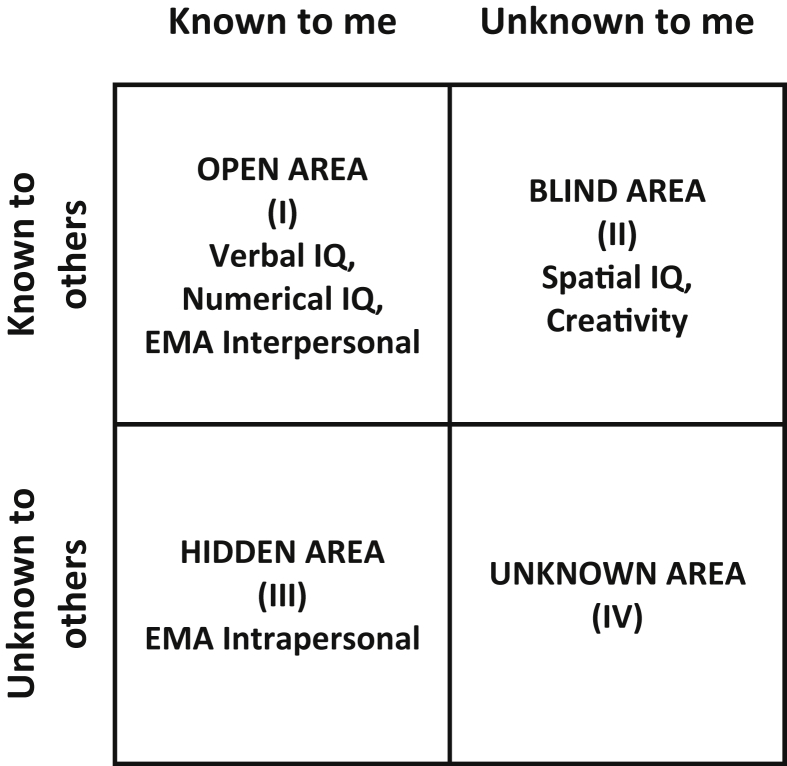
Adaptation of the Johari window (Luft and Ingham, 1955) and hypotheses about abilities. EMA = Emotional Management Ability.